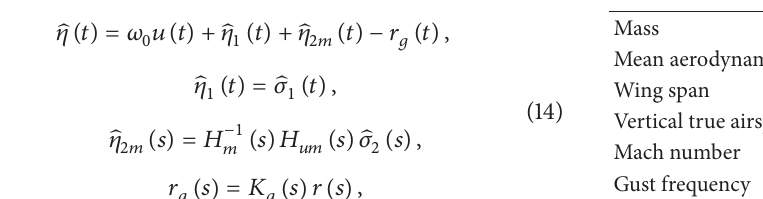
Figure 13: Variation of acceleration and load factor for all the cases in Table 5. Red solid line = Open Loop, Black dotted line = Closed loop. Table 1: Aircraft characteristics and flight